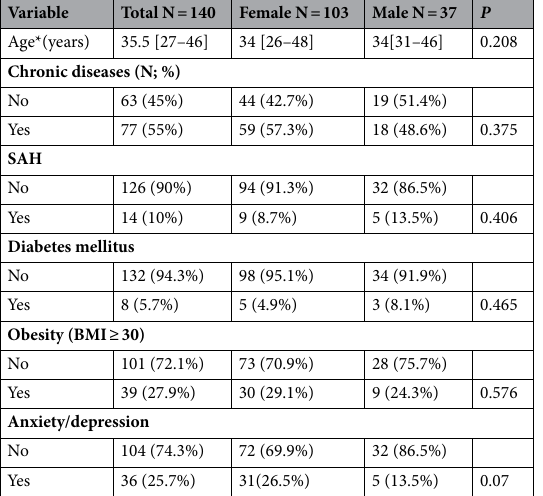
Table 1. Participant characteristics. Source : Prepared by the authors (2022). Chart legend: *Md [1st and 3rd q]; SAH: systemic arterial hypertension; BMI: body mass